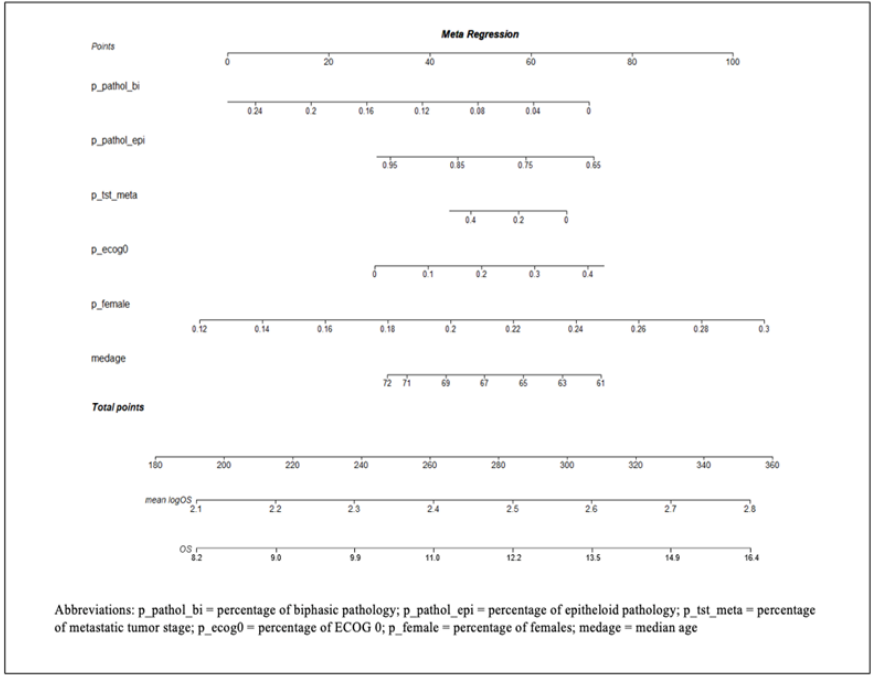
Figure 4. Nomogram model developed to predict overall survival (OS) in patients with malignant pleural mesothelioma treated with platinum/pemetrexed therapy. The mean log OS can be calculated by drawing a vertical line connecting the value of each variable with the point score at the top of the nomogram. The point scores for individual variables are then summed to get a total point score. This is then plotted along the total points line at the bottom of the nomogram. This line is projected to the mean log OS of the trial. Then the exponential of mean log OS is calculated to obtain the OS in months.